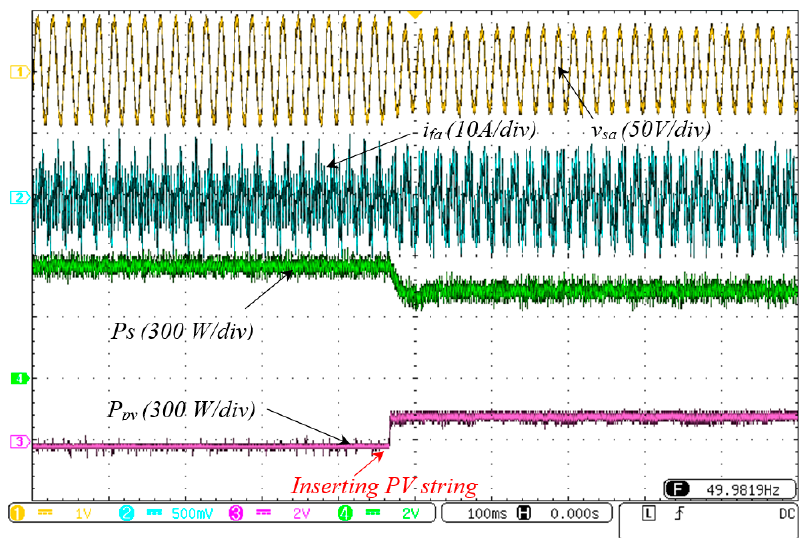
Figure 17. Obtained results in different scenarios.